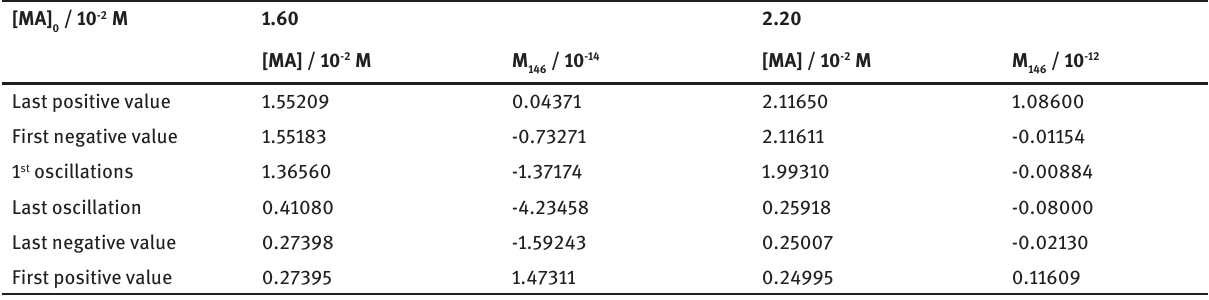
in points where inequality (23) change sign and where bifurcation occurs in Fig. 1N, given as a function of Table 3: Diagonal minor M 146 malonic acid